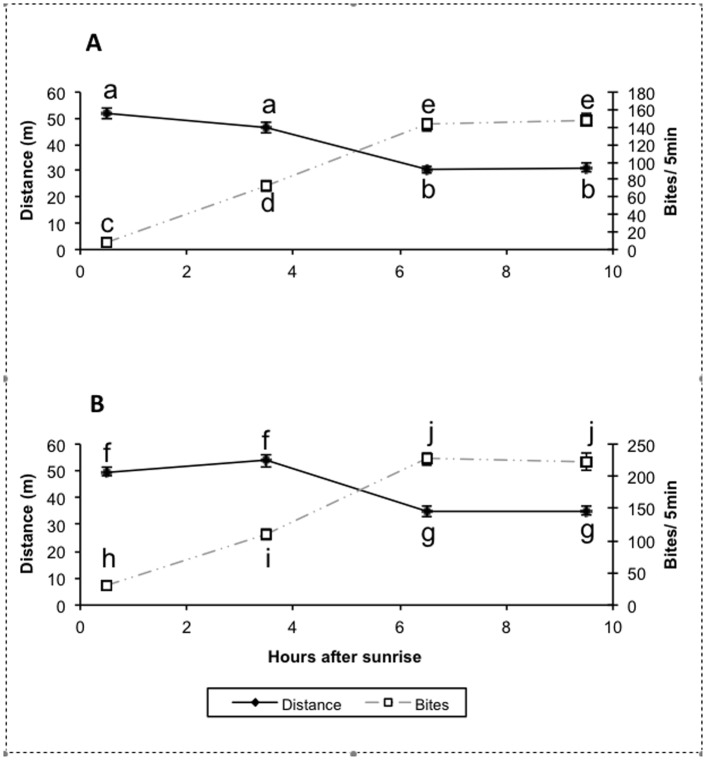
The fish swim longer distances and exhibit lower biting rates at early day hours.Average length (±SE) of swimming tracks (full line) and number of bites (dashes line) exhibited by A Z. xanthurum and B
A. nigrofuscus during 5 min intervals in different times of the day at the shallow reef (<3 m). Post hoc analysis (Tukey) indicated that the data points marked on the figure with the same letters were not significantly different (P>0.9), whereas the differences between those marked with different letters were highly significant (P<0.001).